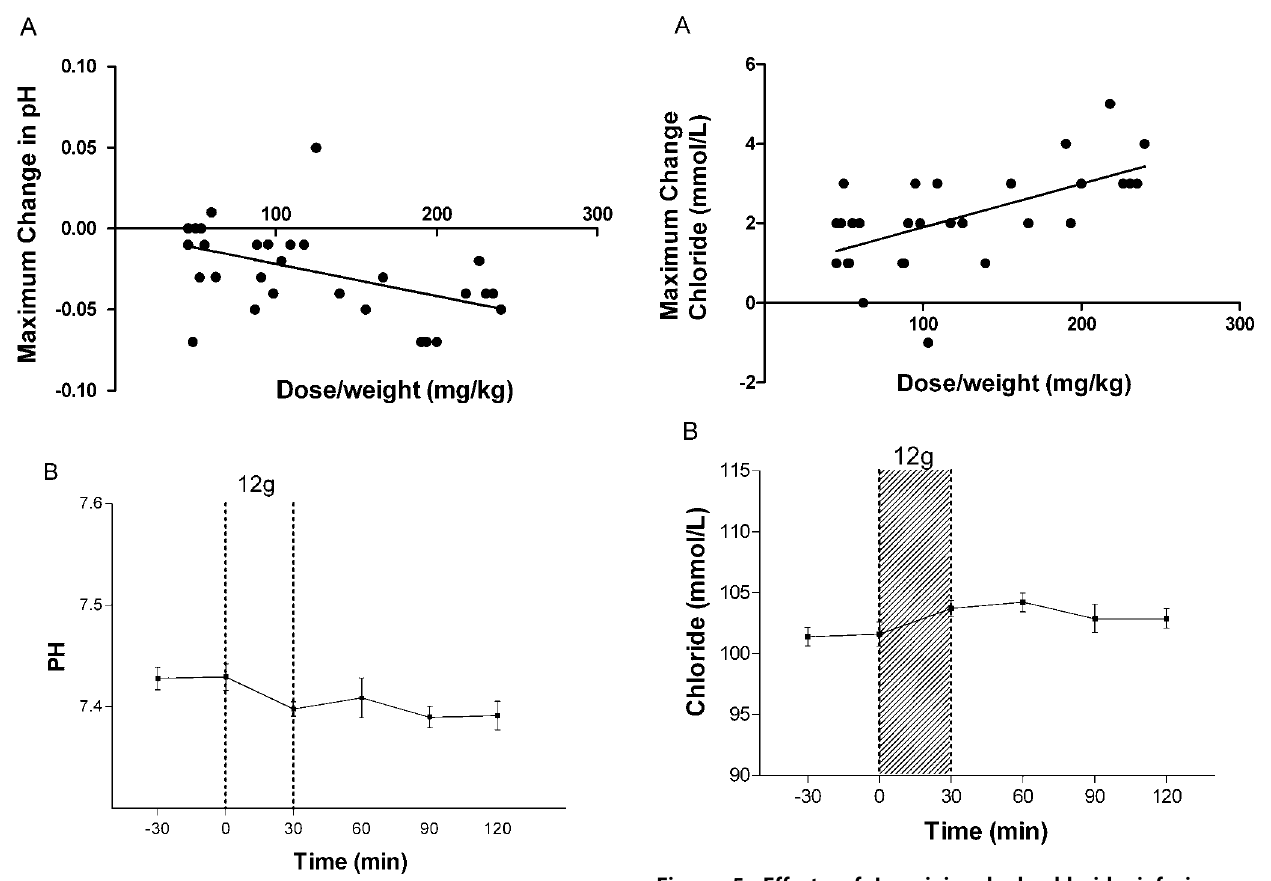
Figure 4. Effects of L-arginine hydrochloride infusion on venous blood pH. Figure 4A: Relationship between dose/weight (mg/kg) of infused L-arginine and the maximal decrease in venous blood pH at any time during or in the two hours following infusion (n=30; r= 2 0.48, p=0.007). Figure 4B: Venous blood pH in patients before and after 30 minute administration of the highest dose of L- arginine (12 g; n=10). Shaded area indicates time of L-arginine infusion. Dots and bars indicate mean 6 SEM.